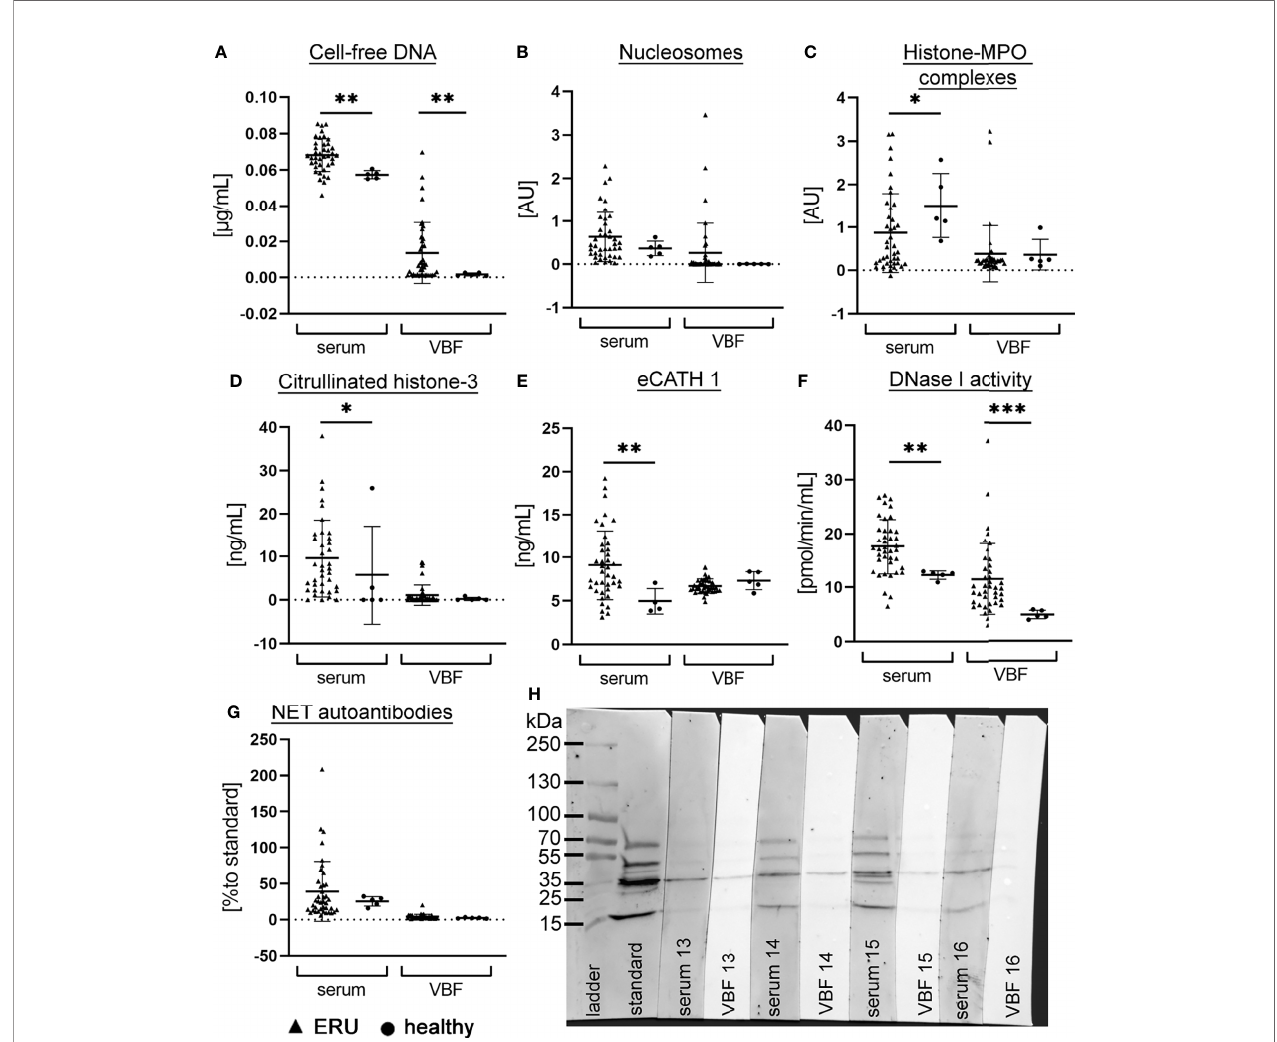
FIGURE 1 | NET markers in serum and vitreous body fl uid (VBF) of ERU patients and control horses. The amount of (A) cell-free DNA, (B) nucleosomes, (C) histone-myeloperoxidase (MPO) complexes, (D) citrullinated histone-3, (E) equine cathelicidin 1, (F) DNase I activity and (G) NET-autoantibodies was analysed in serum and VBF of 40 horses with equine recurrent uveitis (ERU) and fi ve [four sera in eCATH 1] control horses without signs of ERU. For each marker, the individual values and the mean value ± SD of the group is given. An unpaired one-tailed Mann-Whitney test student ’ s t-test was calculated ( p < 0.05, ** p < 0.01 *** p < 0.001). Mean values of serum were higher than in VBF, however a wide range is seen in most markers. In (H) , a representative image (patient no. 13-16) of a Western blot analysis for the detection of autoantibodies against NET proteins in serum and VBF is depicted. The standard is one identical serum sample that was included in each blot to enable quanti fi